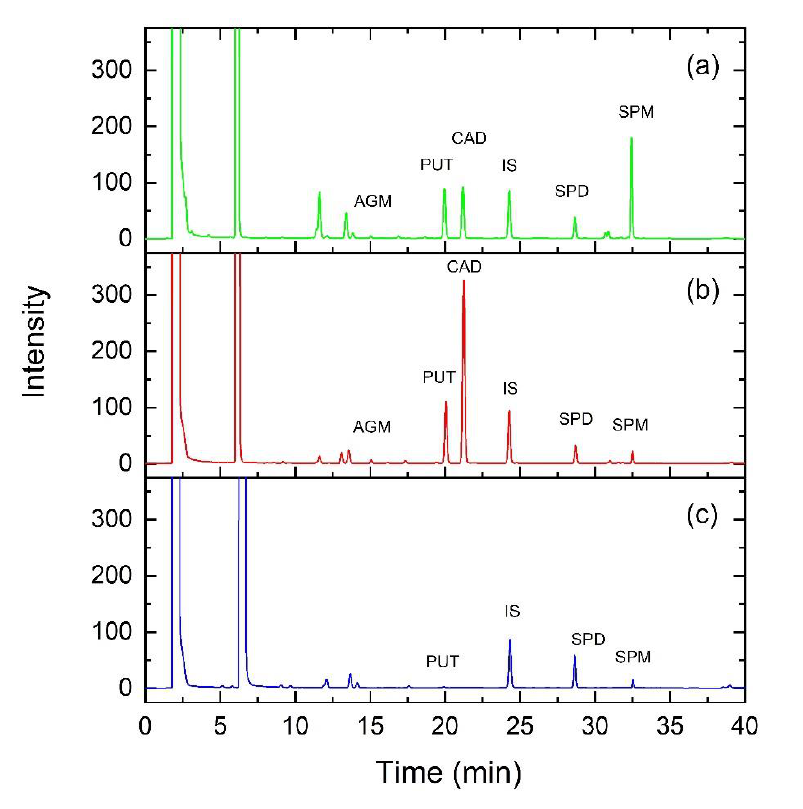
Figure A3. Chromatograms of dansylated 1,7-diaminoheptane (IS) and the polyamines agmatine (AGM), putrescine (PUT), cadaverine (CAD), spermidine (SPD), and spermine (SPM) extracted from ( a ) microgreens, ( b ) sprouts, and ( c ) ungerminated seeds of fenugreek—fluorescence detector (350/520 nm).